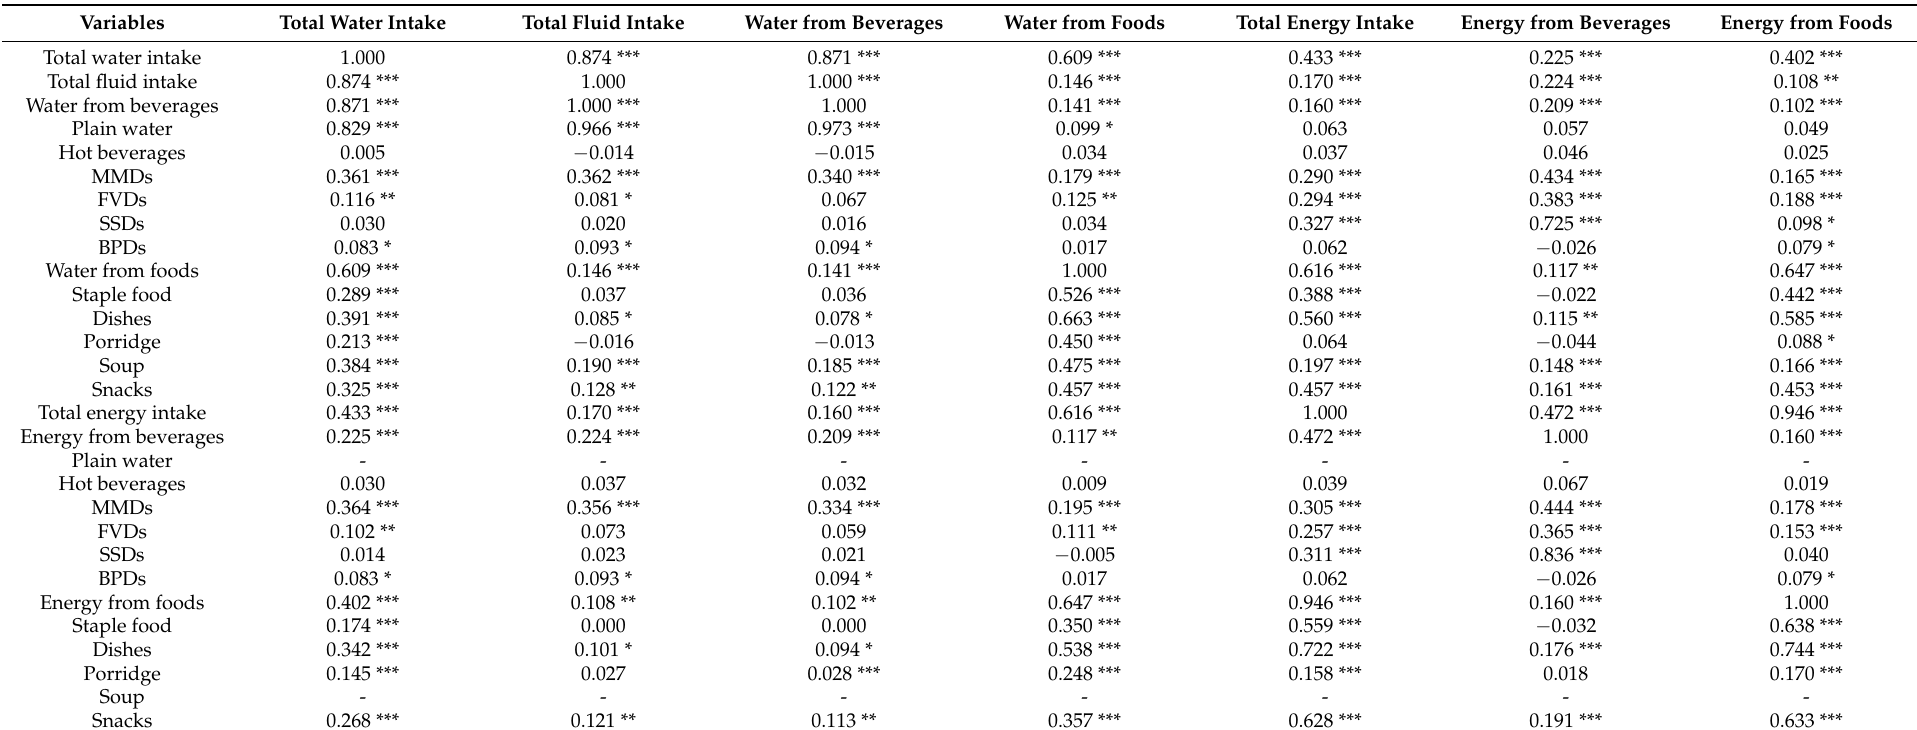
Table 4. Partial correlation between the water and energy intake of different sources and total water intake, total fluid intake, water from beverages and foods, total energy intake, energy from beverages and foods (adjusted for age and gestational